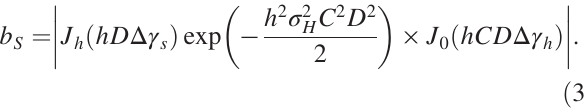
FIG. 2. The evolution of bunching factor with the harmonic number, the red circle is Gaussian results, blue square and the black diamond is for uniform and saddle respectively, the corresponding color line is theoretical derivation of Eqs. (2) –